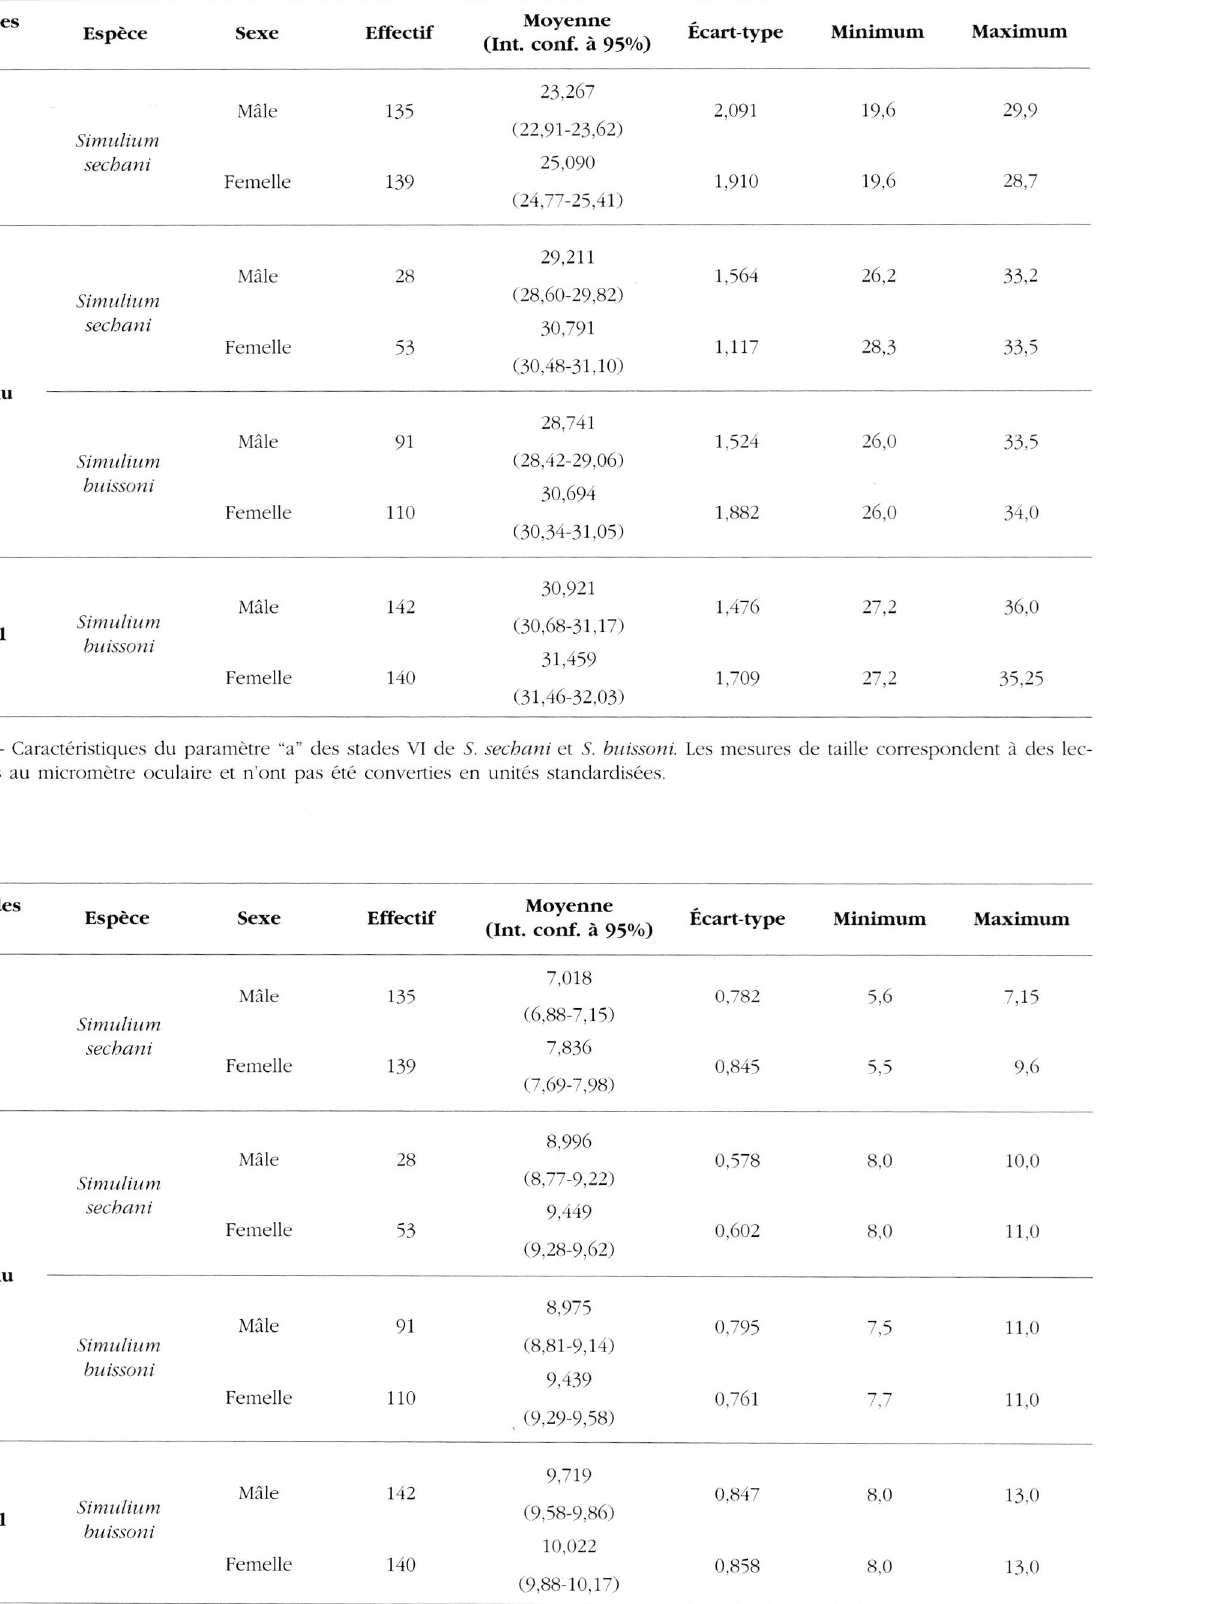
Tableau V. — Caractéristiques du paramètre "b" des stades VI de 5. sechani et 5. buissoni. Les mesures de taille correspondent à des lec tures directes au micromètre oculaire et n'ont pas été converties en unités